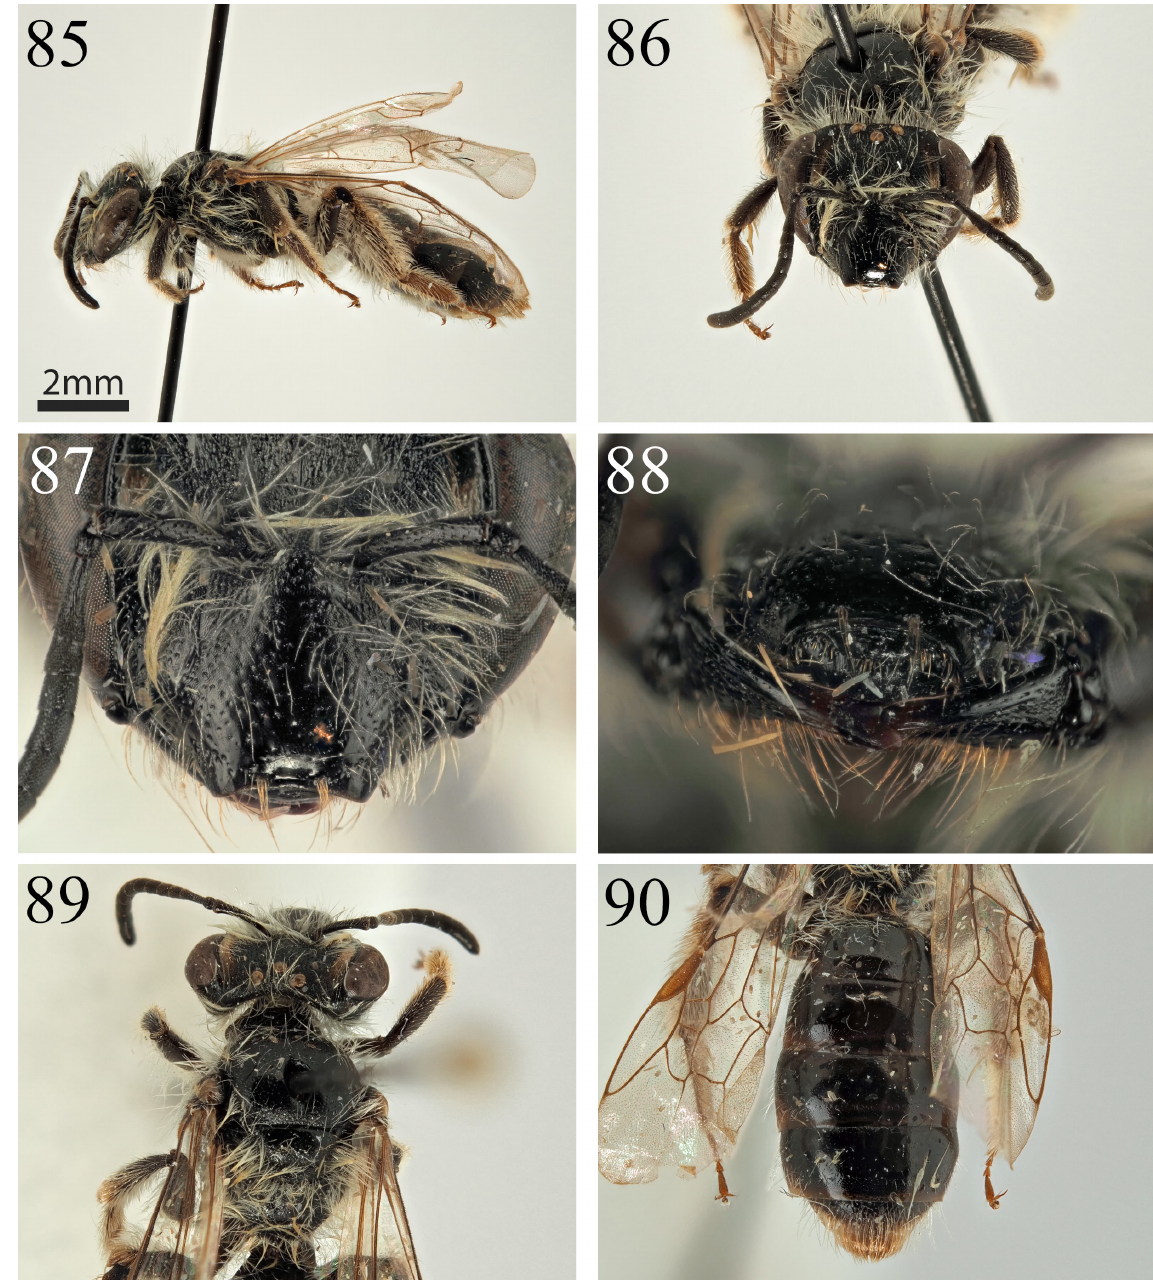
Figs 85–90. Andrena flagrans Wood sp. nov., ♀ (OÖLM). 85 . Profile. 86 . Face. 87 . Face, detail. 88 . Process of labrum. 89 . Dorsum. 90 .